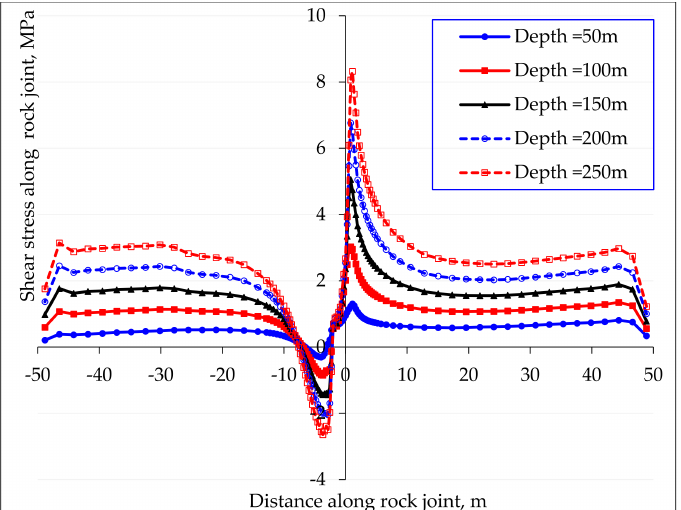
Figure 24. Shear stress along a rock yielded joint that runs beneath the tunnel opening at various tunnel depths below